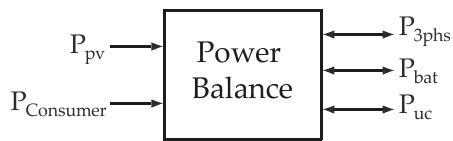
Figure 10. Block diagram of the power balance system of the HRES.